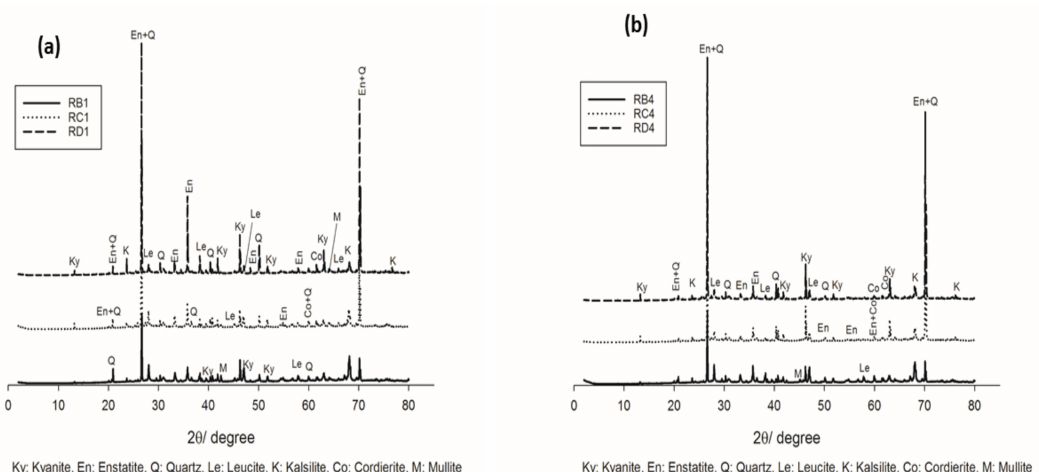
Figure 3. XRD patterns of the refractory geopolymer composites at 1050 ◦ C: ( a ) with 70 wt.%. of kyanite added and ( b ) with 85 wt.% of kyanite